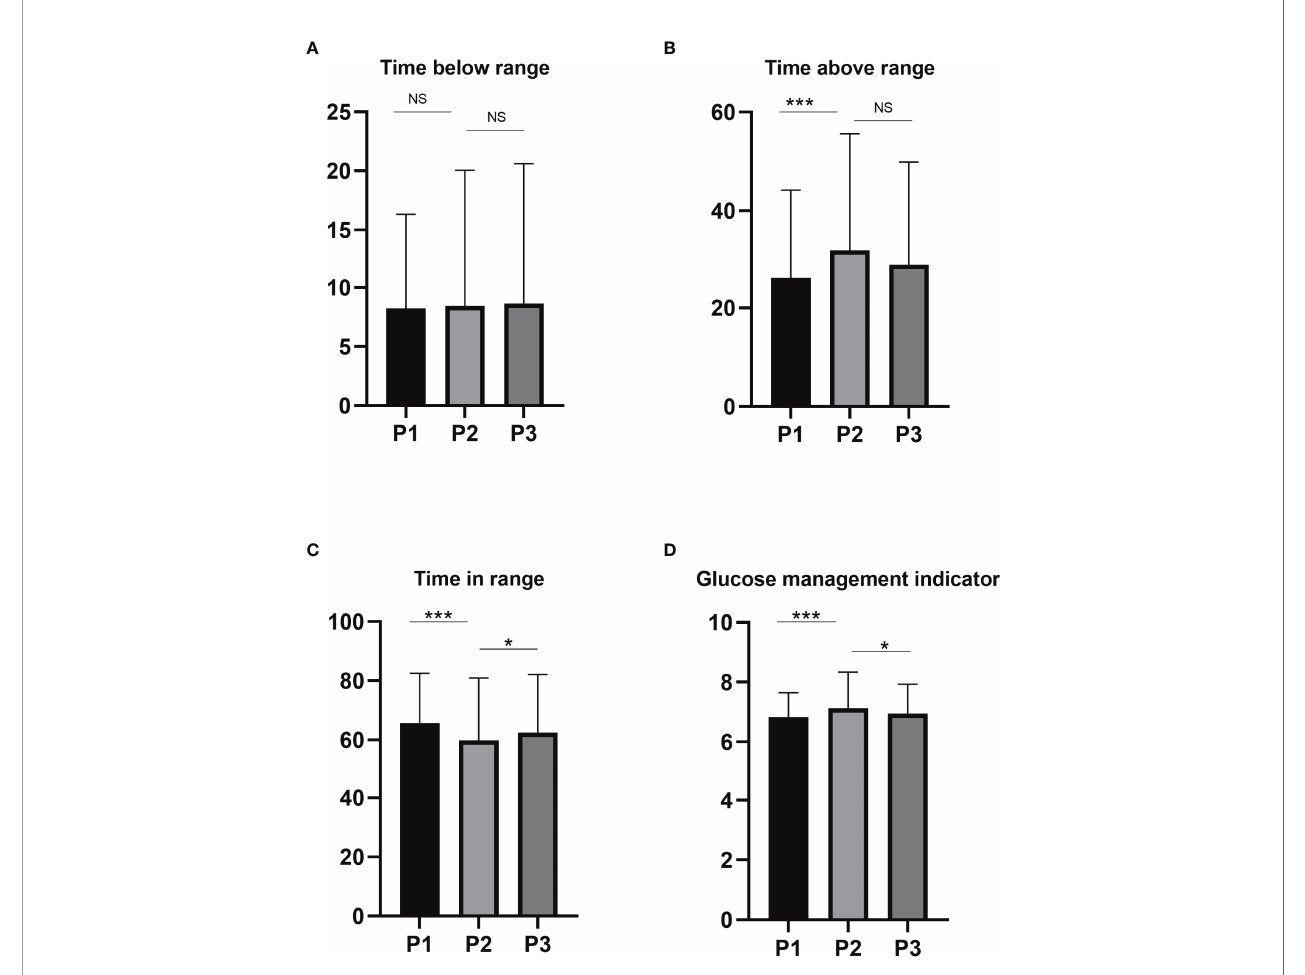
FIGURE 1 | Changes in glycemic indices TBR (A) , TIR (B) , TAR (C) and GMI (D) before, during and after the Chinese New Year public holiday. Abbreviations: GMI, glucose management indicator; TIR, time in range; TAR, time above range; TBR, time below range, P1, the period before the Chinese New Year public holiday; P2, the period during the Chinese New Year public holiday; P3, the period after the Chinese New Year public holiday.NS, not signi fi cant; * P < 0.05; *** P < 0.001.